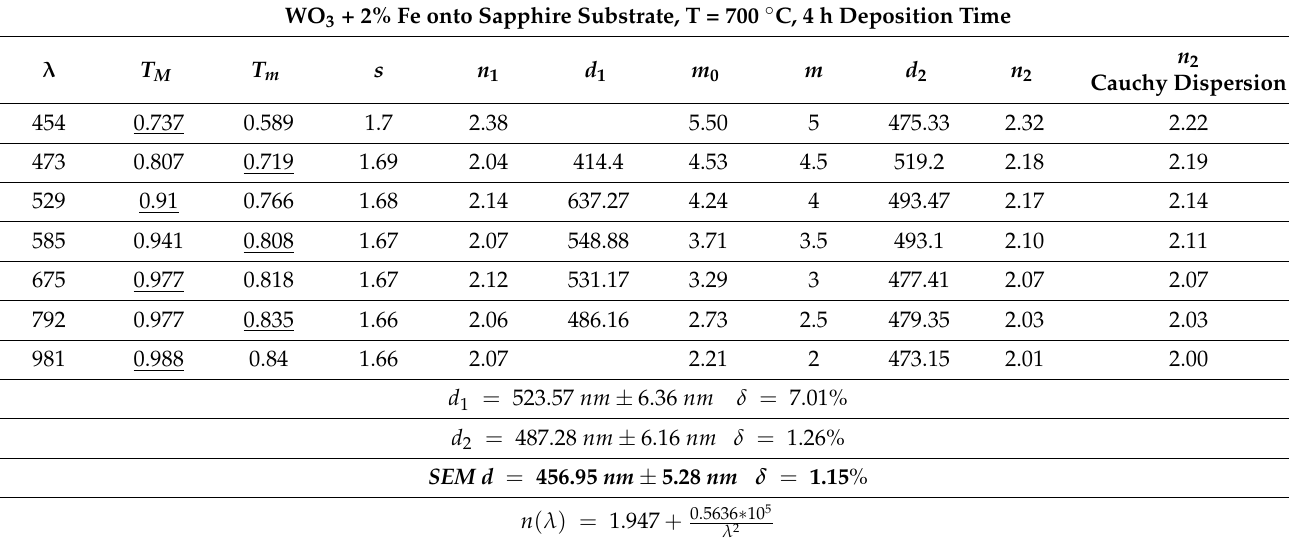
Table 2. The parameters obtained for WO 3 + 2% Fe layer sample grown at T = 700 ◦ C and 4 h deposition